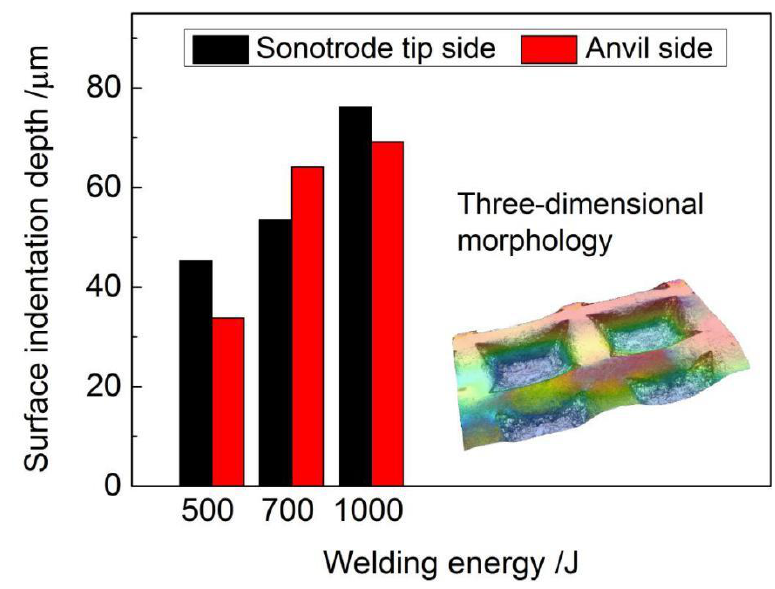
Figure 3. Indentation depths of different samples.